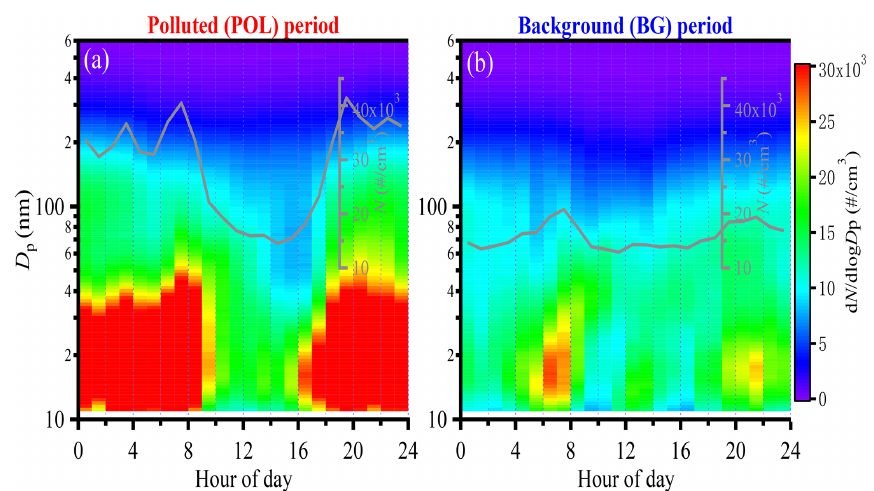
Figure 4. Diurnal variations in aerosol particle number size distribution (colored background) and total aerosol number concentration ( N , shown as grey curves) during the (a) POL and (b) BG periods.